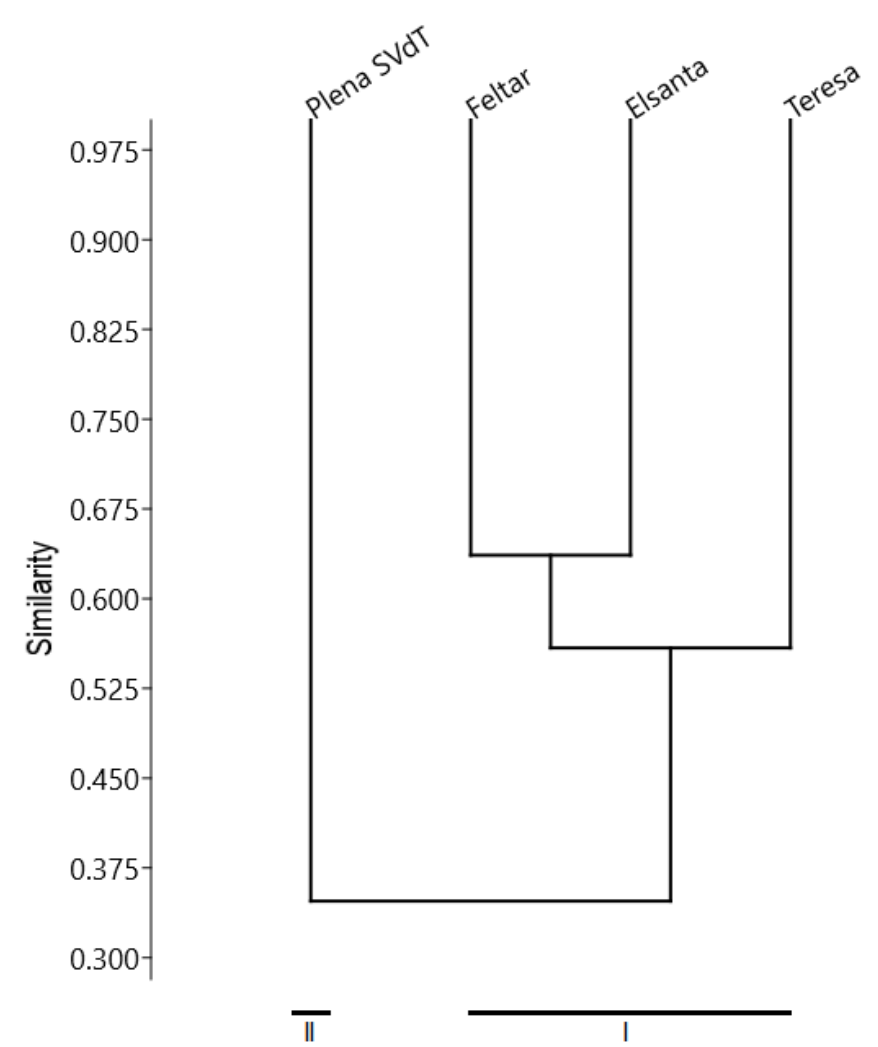
Figure 1. UPGMA dendrogram showing genetic similarity between the analyzed strawberry mi- croclones resistant to Phytophthora disease.